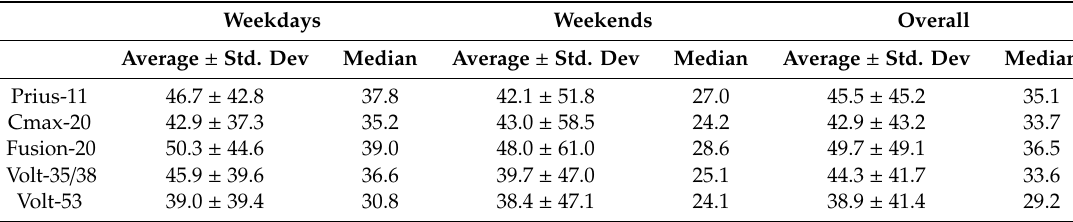
Table 4. Daily VMT Summaries by type of